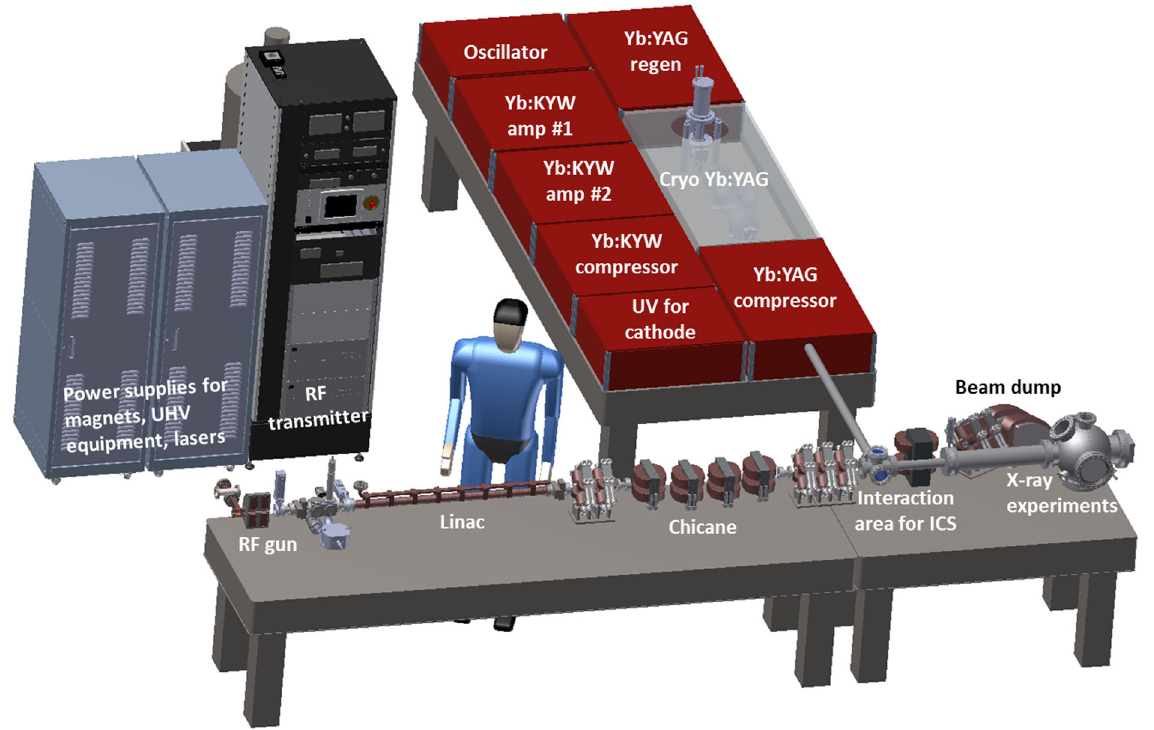
FIG. 2. CAD layout of the components for the compact x-ray source showing the lasers including Yb ∶ KYW that produces electrons via photoemission and the cryo Yb ∶ YAG amplifier used for ICS. Accelerator components shown include the rf gun, short linac, and transport magnets. The cabinets house the rf transmitter and power supplies for magnets, vacuum equipment, and